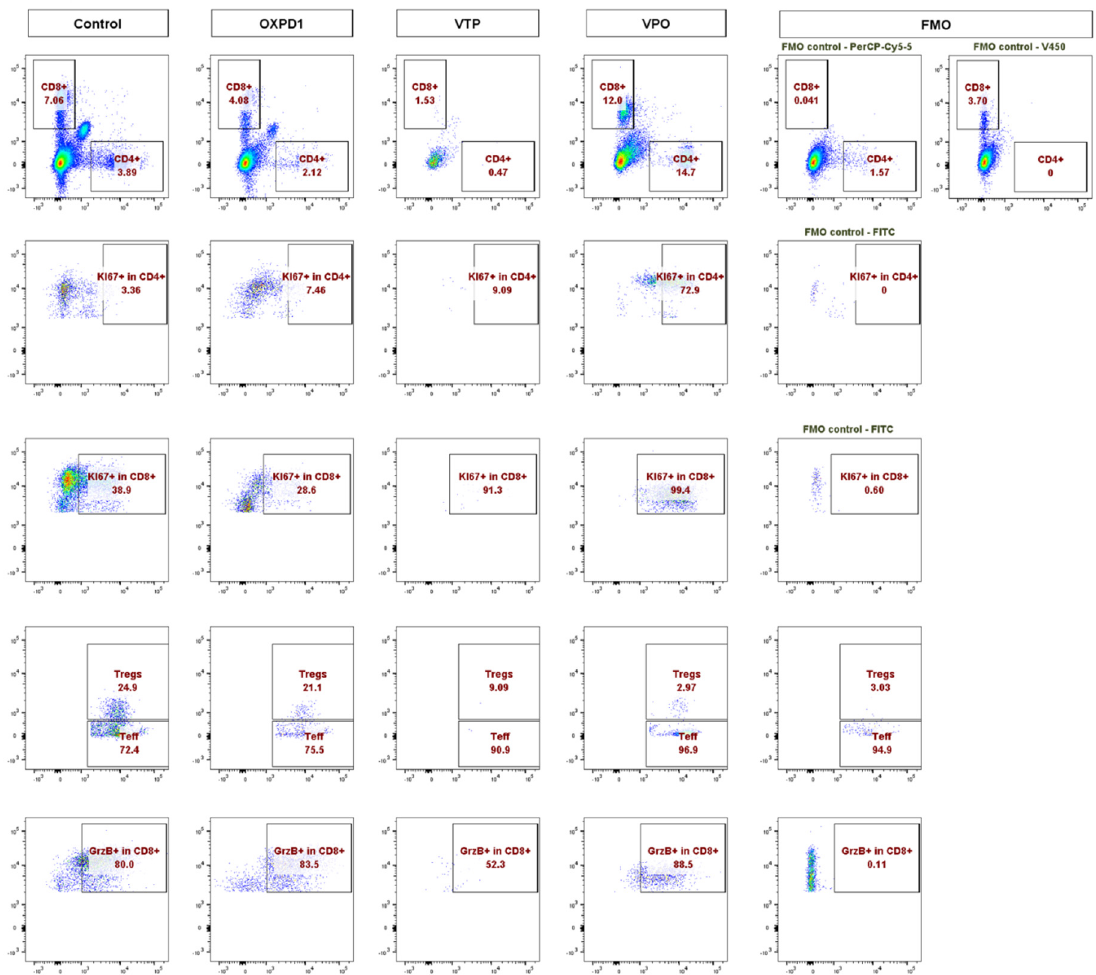
Figure 3. Adding PD-1 Inhibitor and OX40 agonist to VTP therapy increases T cell infiltration and activation compared to VTP alone, into MB-49 UTUC allografts at 7 days post-treatment. Representative flow cytometry plots showing the percentage of CD4 + and CD8 + cells among CD45 + cells (top row), Ki67 + in CD4 + (second row), Ki67 + in CD8 + (third row), Foxp3 + Tregs and Foxp3 − Teff in CD4 + (fourth row), and GrzB + in CD8 + T cells (bottom row) in control and treated tumors analyzed 7 days after treatment. A fluorescent minus one (FMO) sample was included for each marker as a negative control for gating.